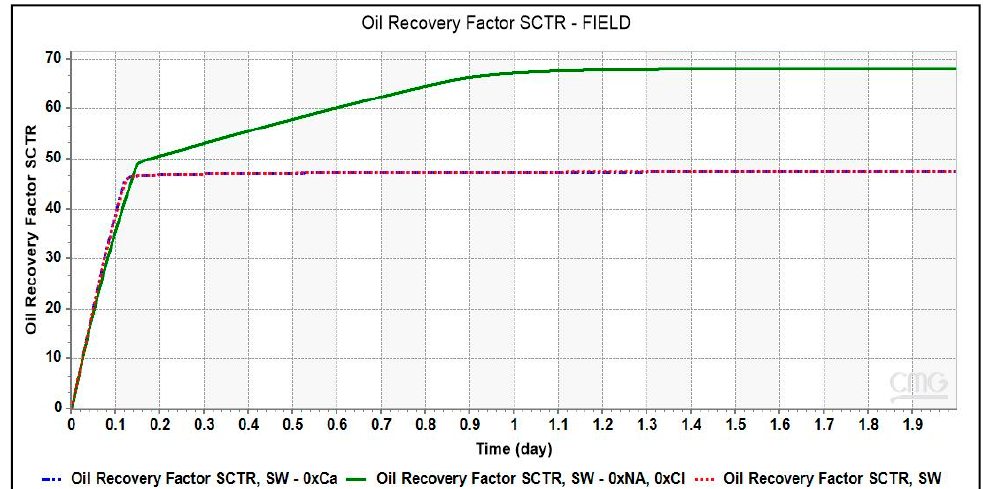
Figure 9. Oil Recovery factor vs. brine pore volume injected for different smart brines from simulation results. Depleting SW of monovalent ions, Na + and Cl − ions have more dominant effect than removing the divalent Ca 2+ ions from SW.